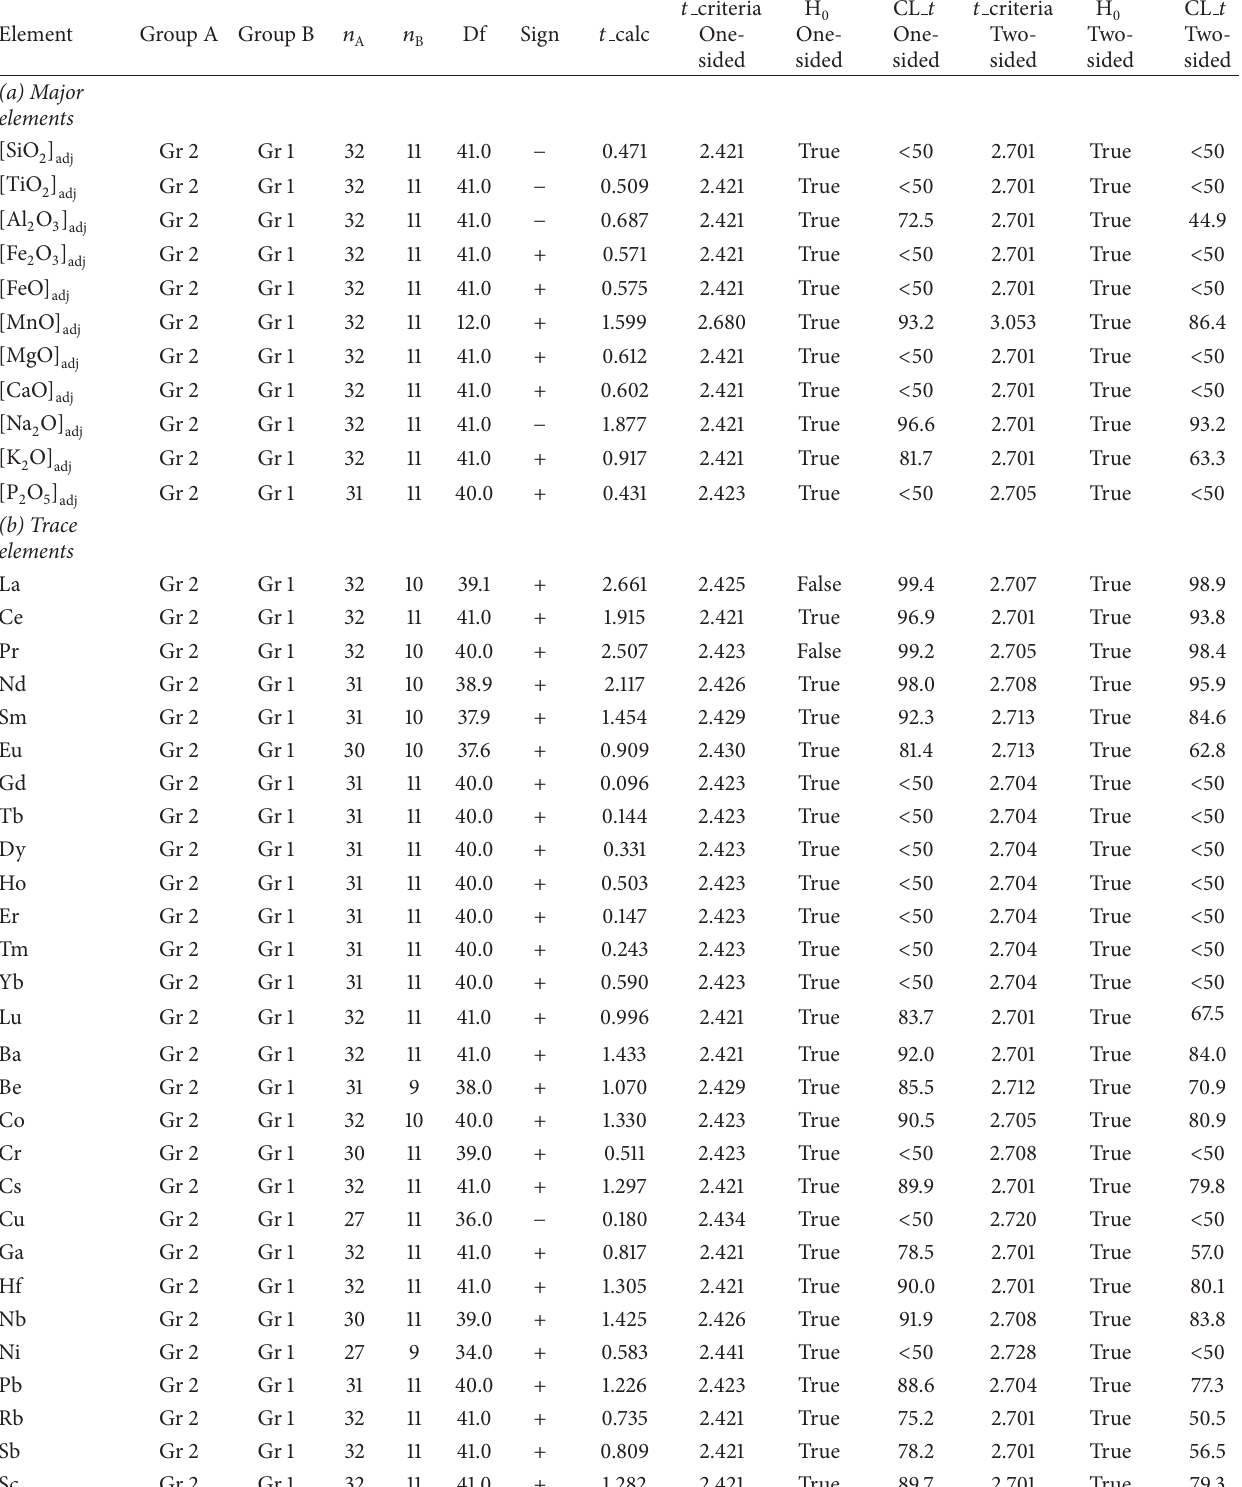
Table 8: Results of the application of significance tests of Fisher 𝐹 and Student 𝑡 to the acid rock data from the Sierra de las Cruces at the strict 99% confidence level (CL) prepared from Excel output of UDASYS